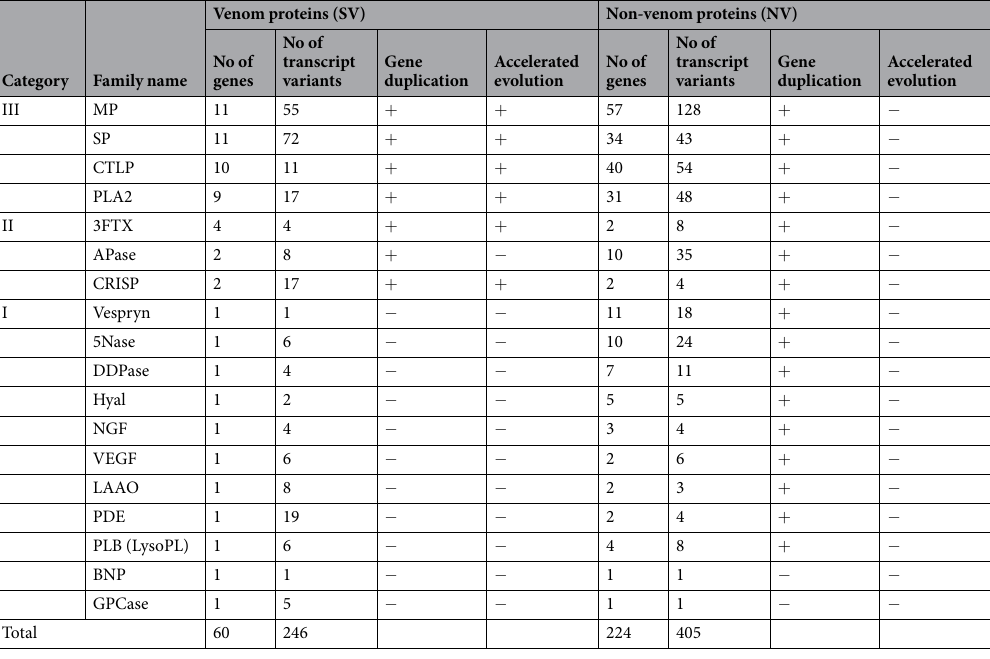
Table 1. Snake venom (SV) genes and non-venom (NV) paralogs identified in the Protobothrops flavoviridis genome. Variation in SV gene transcripts were compiled from almost full-length RNA-seq data of venom gland using PacBio. Variation in NV gene transcripts were compiled from the HabAm1 gene model with RNA-seq data of other